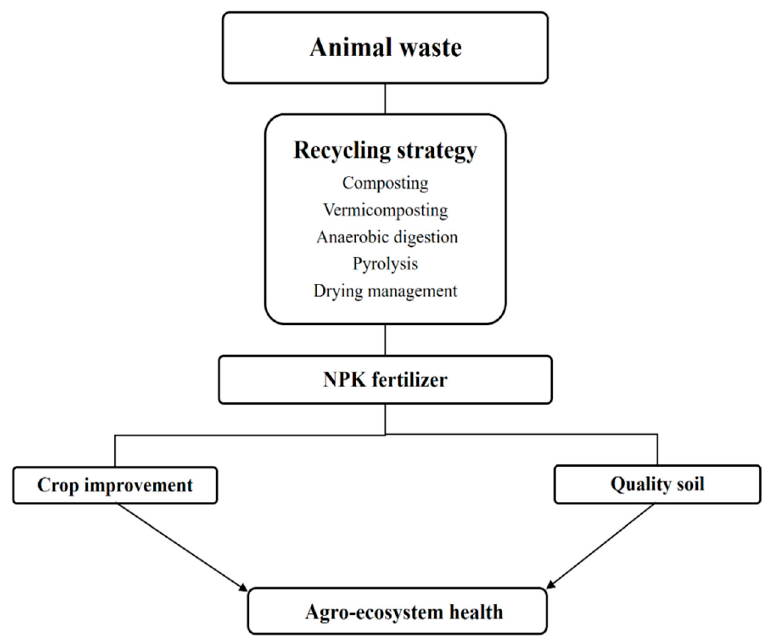
Figure 2. An approach to achieve agricultural sustainability through waste to fertilizer conversion.